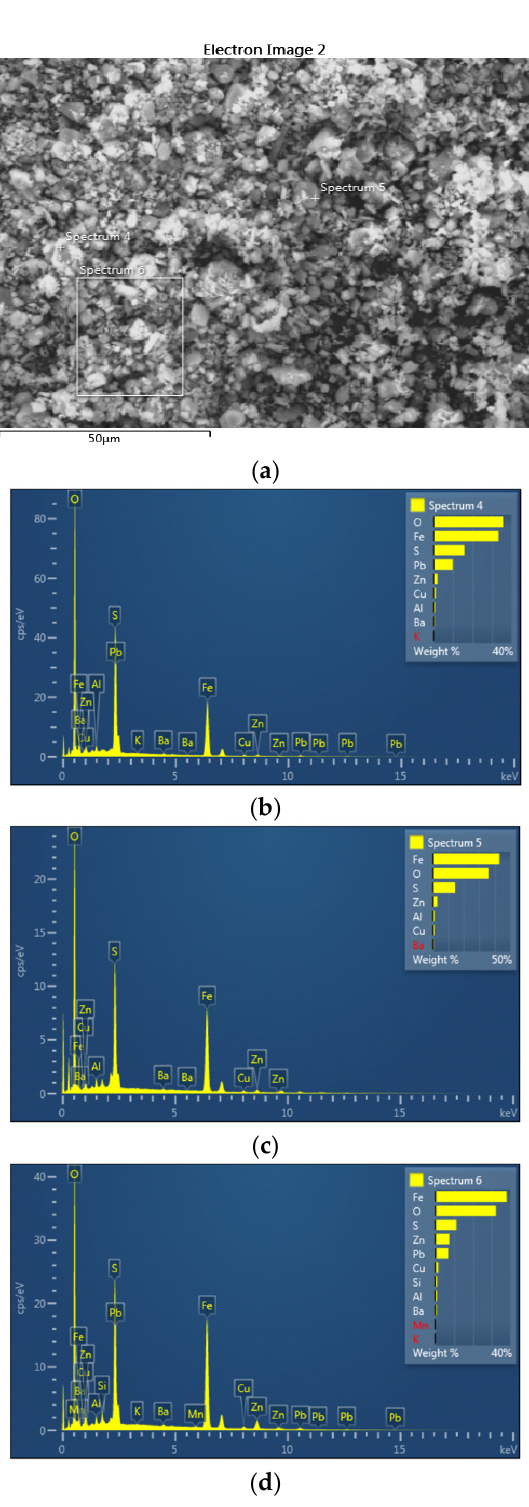
Figure 6. EDS image ( a ) with EDS spectra ( b – d ) of the jarosite sample recorded at 1000× magnification; second position.